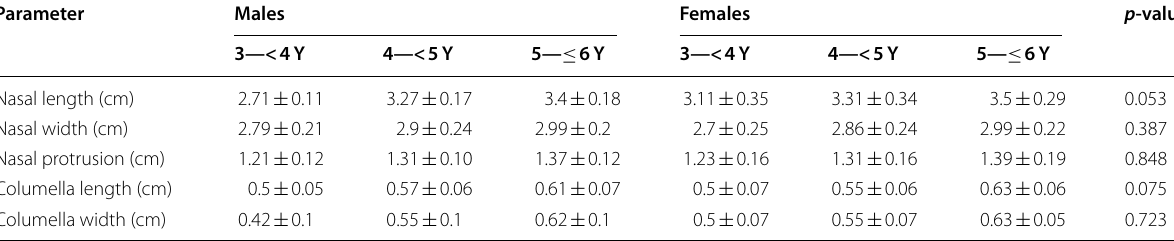
standard deviation (SD) ±